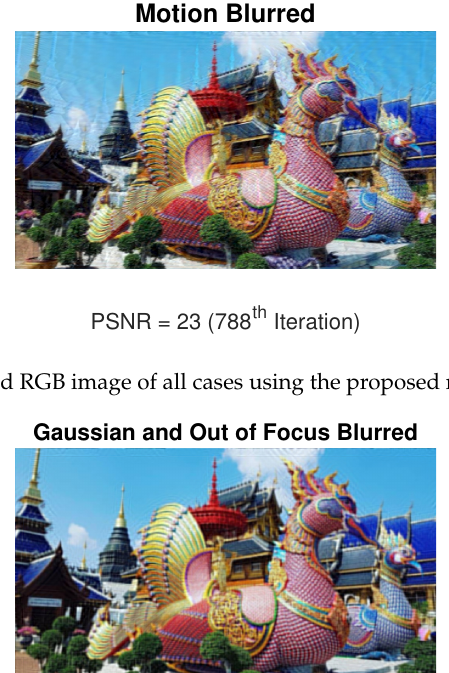
Figure 44. The reconstructed RGB image of all cases using the proposed method (2) with PSNR = 23.